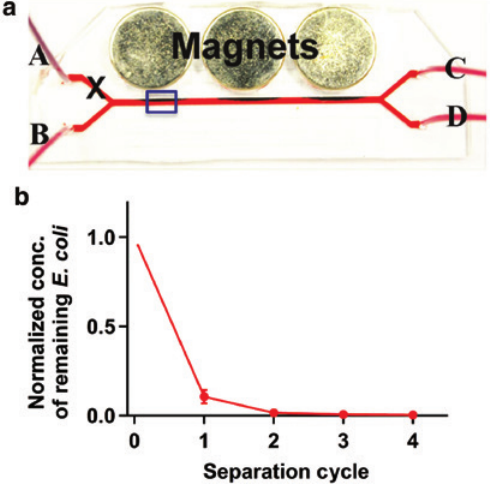
Figure 5: Magnetic separation of bacteria from whole blood utilizing synthetic ligand-coated MNPs. Blood sample spiked with fluores- cently labeled E. coli was incubated with MNPs having synthetic affinity ligand and then infused through inlet B, while A is closed and exited through outlets C and D. Placement of three permanent magnet caused E. coli bound with MNPs to exit from inlet C